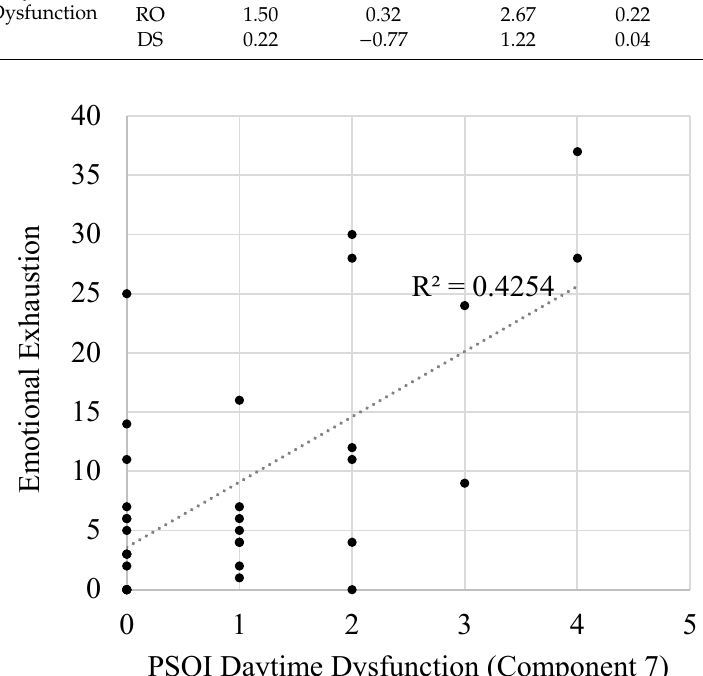
Figure 1. A correlation linking poor sleep quality as measured by PSQI daytime dysfunction attributed to poor sleep quality (component 7) with higher emotional exhaustion.